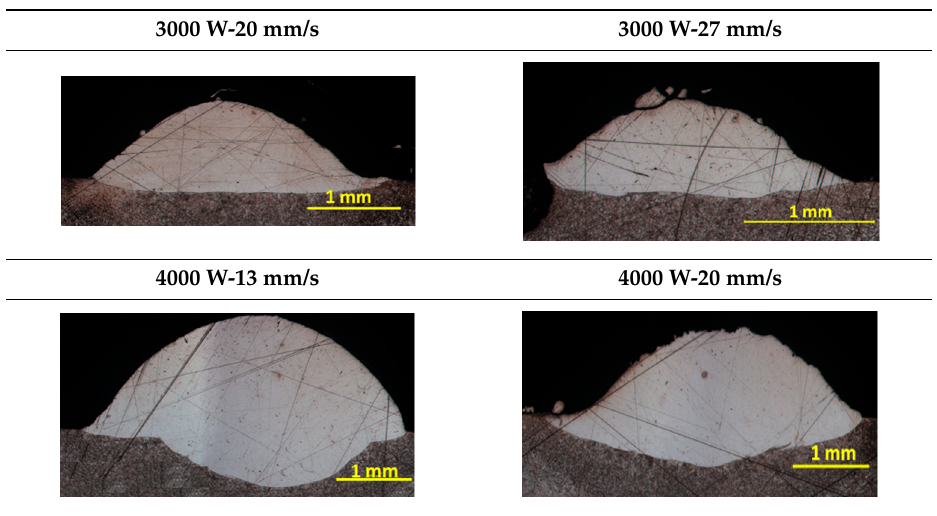
Table 5. Experiments with powder flow of 31 g/min.